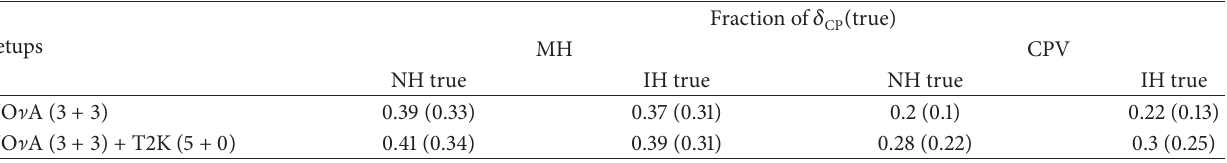
Table 3: Fractions of true values of 𝛿 for which a discovery is possible for mass hierarchy and CP violation. The numbers without (with) CP parentheses correspond to 90% (95%) CL. Here we take the central value for sin 2 𝜃 13 to be 0.023 as predicted by Daya Bay. For sin 2 𝜃 23 , the best-fit value that we consider is 0.413. The results are shown for both NH and IH as true hierarchy. This table has been taken from [72].